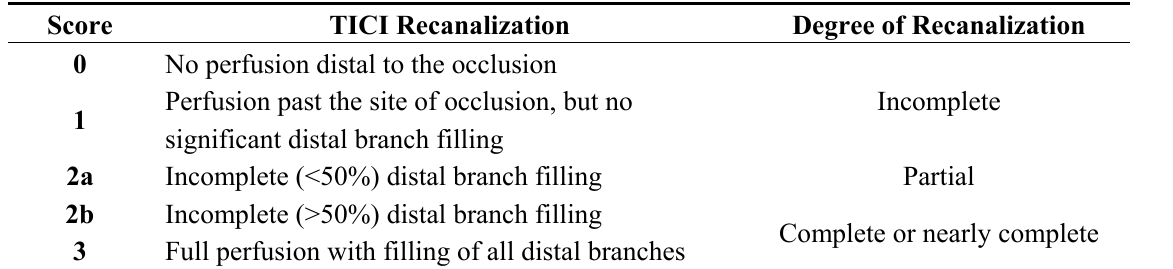
Table 1. Description of thrombolysis in cerebral infarction (TICI) score and corresponding degree of recanalization used in this case